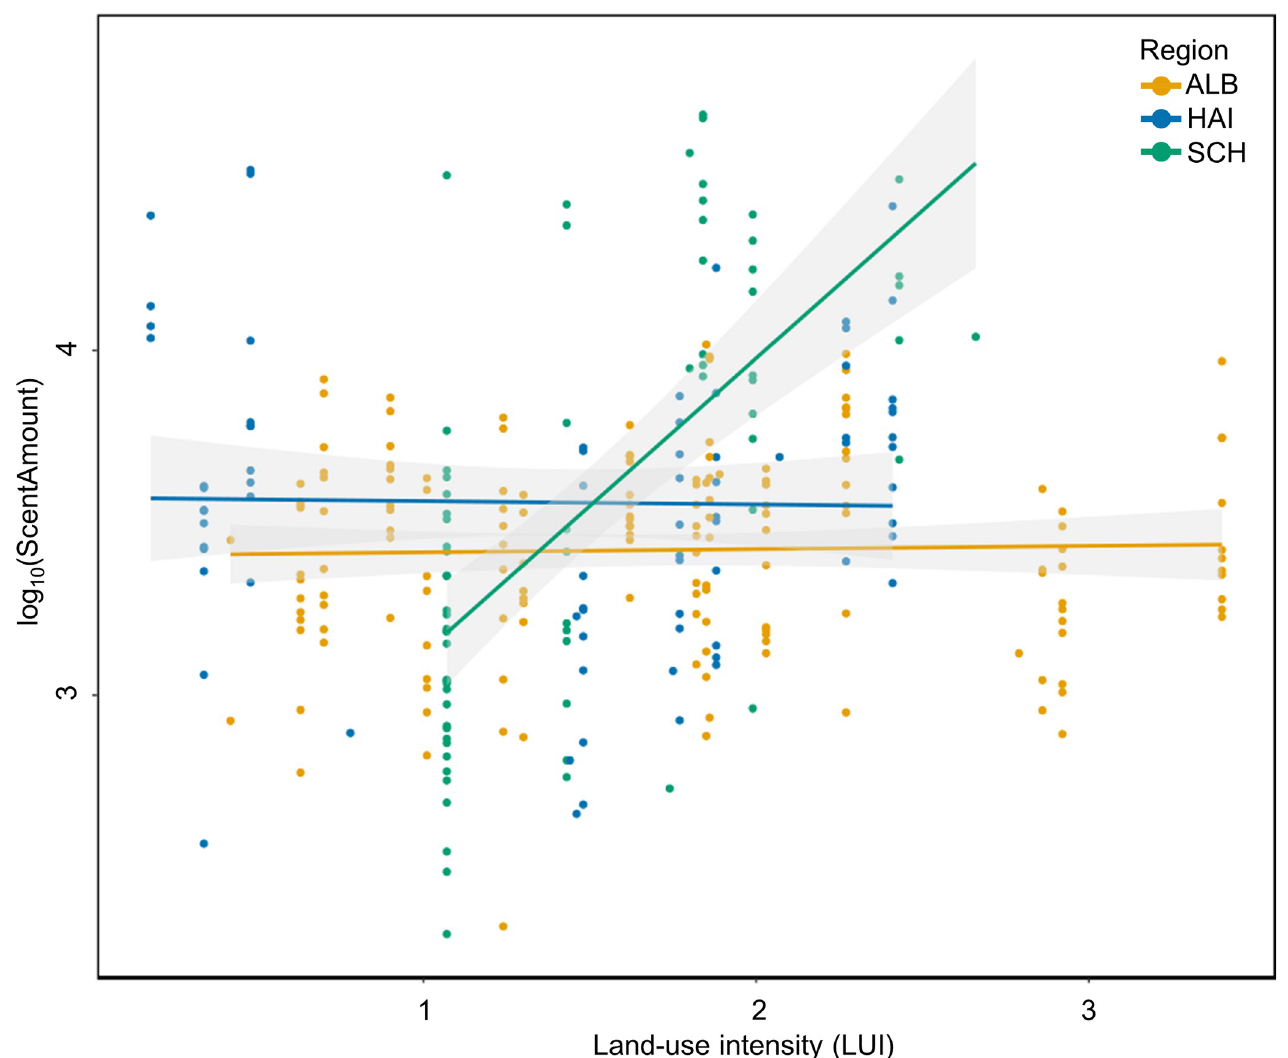
Fig 3. Effects of land-use intensity index LUI and of region on scent amount of B . lapidarius workers. LUI alone had no effect on scent amount, but an interaction occurred between LUI and region (LMM: χ 2 = 11.613, N = 307, p < 0.01). Regression lines for each region, namely Schwa¨bische Alb